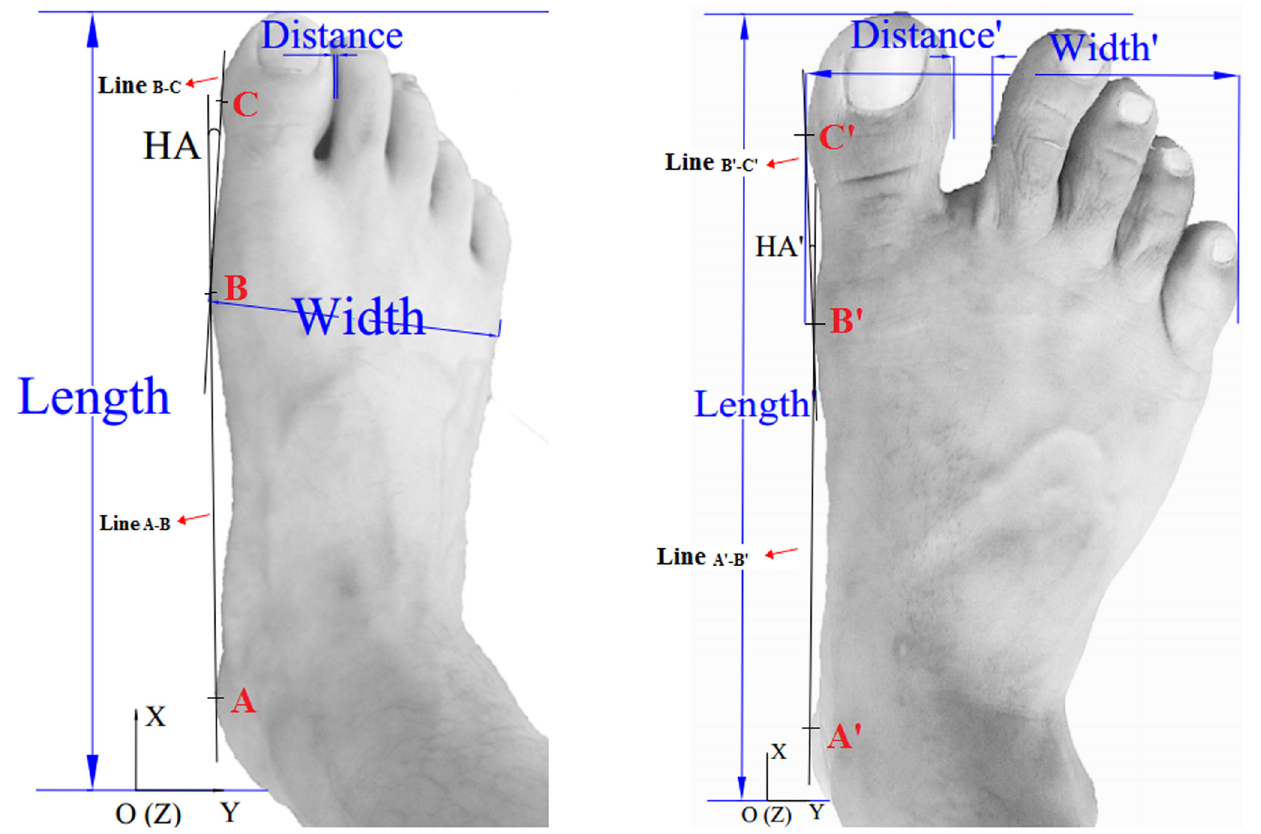
Fig 2. The dorsal view of foot surface data, length (length ’ ), width (width ’ ), minimal distance (distance ’ ) and HA (hallux angle, HA ’ ). Three landmarks were drawn to connect line A-B (A ’ -B ’ ) and line B-C (B ’ -C ’ ), with A (A ’ ) in medial calcaneous, B (B ’ ) in the head of the first metatarsophalangeal joint and C (C ’ ) in the